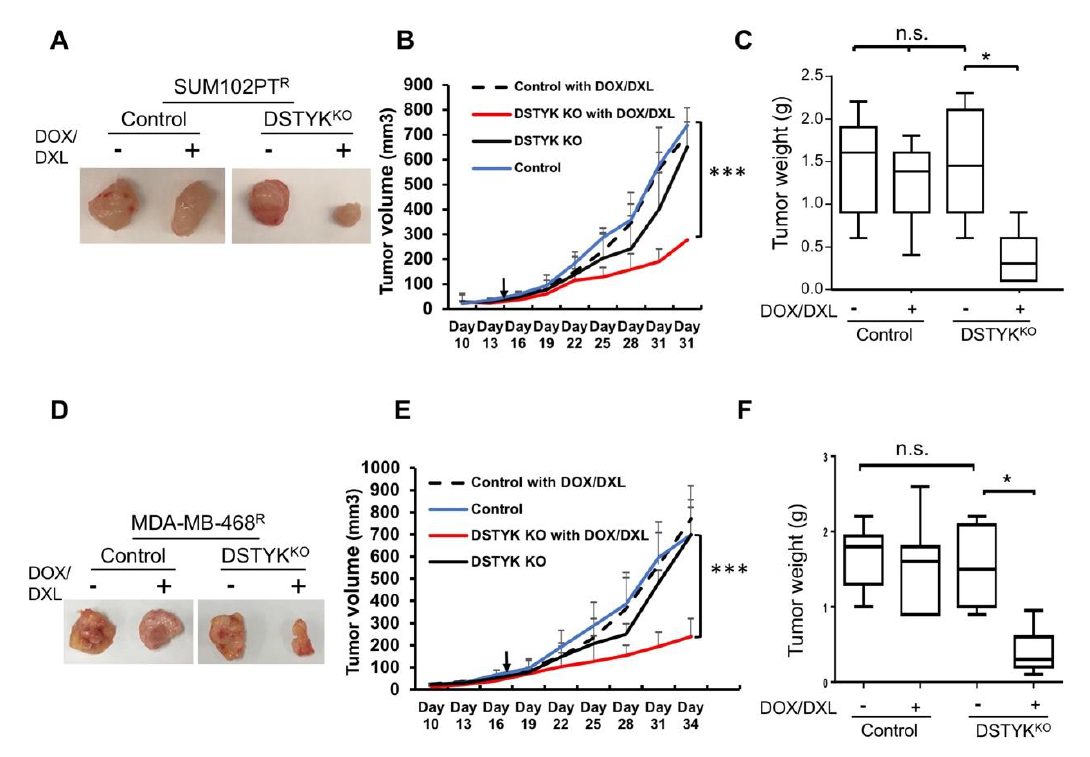
Figure 6. DSTYK promotes chemoresistance in vivo . ( A ) Representative images of one set of tumors derived from control and DSTYK KO SUM102PT R cells. ( B ) The graph represents the tumor growth volume observed for the different groups (as labeled) derived from SUM102PT R cells. The data represents mean values ± SD. ( C ) Quantification of tumors after excision and being weighed at the end point; n = 7; n.s., not significant; * p < 0.05; *** p < 0.001, one-way ANOVA. ( D ) Representative images of one set of tumors derived from control and DSTYK KO MDA-MB-468 R cells. ( E ) The graph represents the tumor growth volume observed for the different groups derived from MDA-MB-468 R cells (as labeled) until reaching the endpoint. The data represents mean values ± SD. ( F ) Quantification of tumors after excision and weighing at the end point; n = 7; n.s., not significant; * p < 0.05; *** p < 0.001, one-way ANOVA.